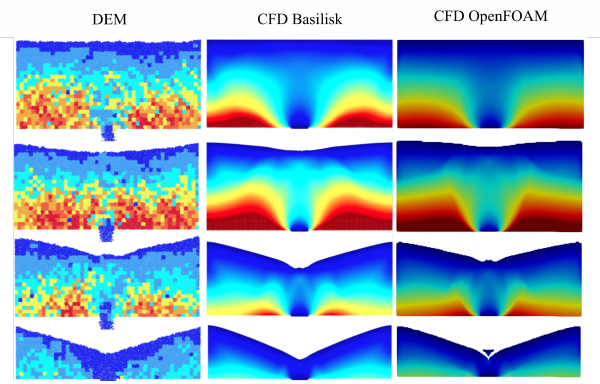
Figure 2. Pressure field for di ff erent stages during discharge.